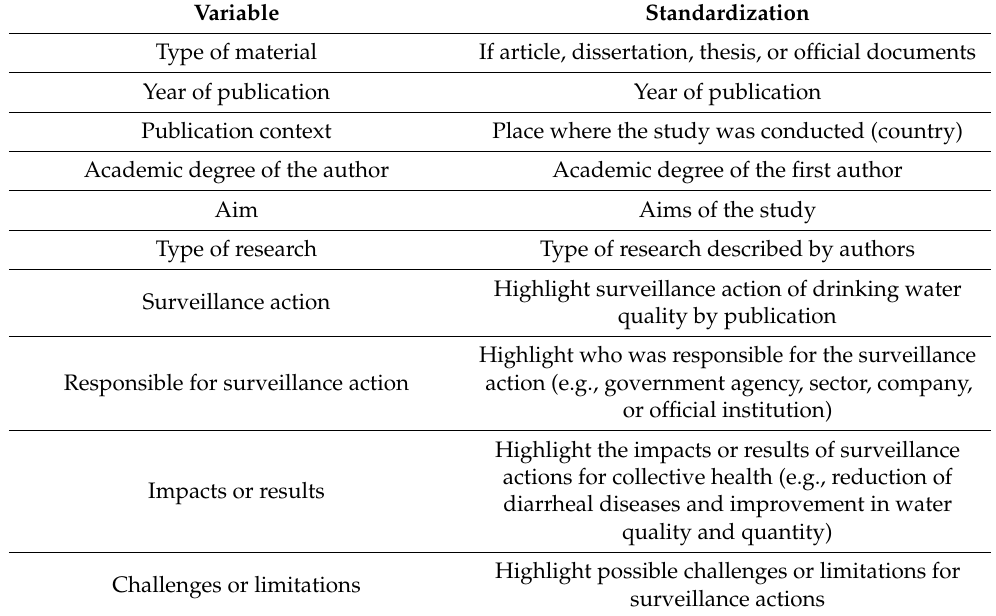
Table 3. Instruments for data